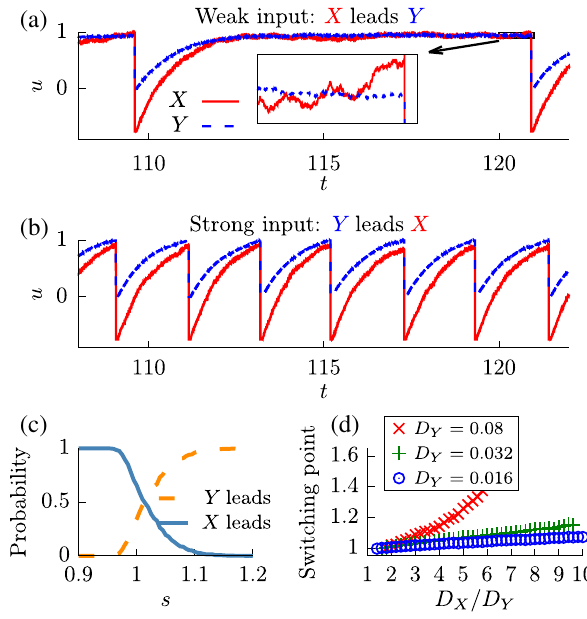
FIG. 2. Noise gating in coupled integrate-and-fire units. (a) Membrane potential response of Y (somatic, blue dashed line) and X (dendritic, red full line) units for s ¼ 0 . 95 and 3 D D . Inset: Expanded view near threshold, where the X X ¼ Y unit crosses first (arrow). (b) Same as (a) but for stronger input s ¼ 1 . 15 . (c) Entrainment probability for a range of input strengths, as described in the caption of Fig. 1 The time window used to establish leadership in the integrate-and-fire model is of the same order as the integration time step. The input intensity where entrainment probabilities cross is the switching point. =D (d) Dependence of the switching point on D for different X Y values of D . Parameters are described in Y